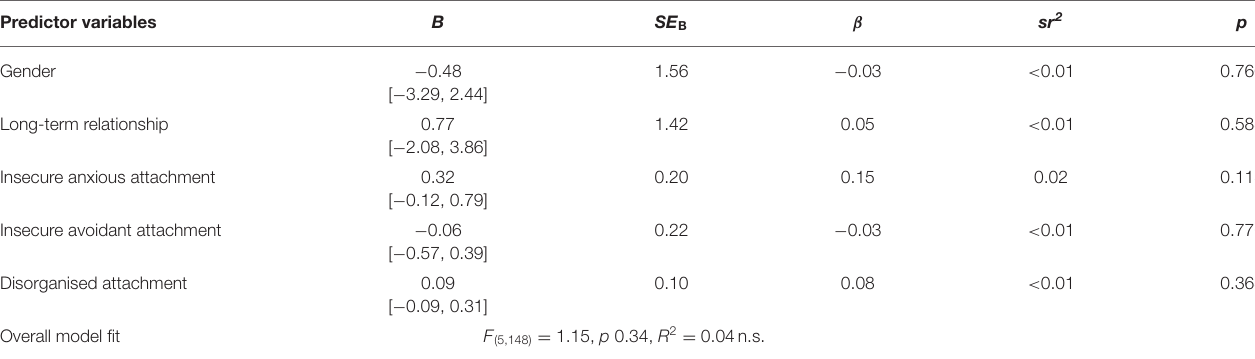
TABLE 2 | Summary of multiple regression analysis predicting controlling caregiving.